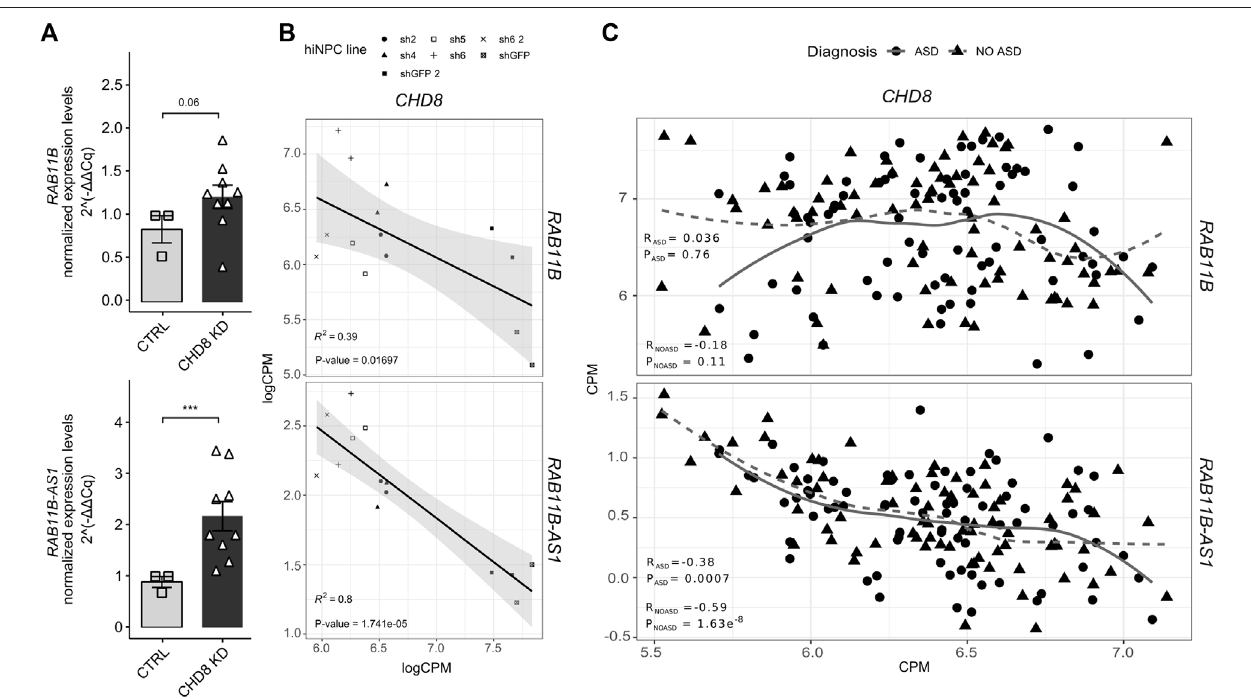
FIGURE 2 | RAB11B-AS1 and CHD8 display inversely correlated expression. (A) The barplots report RAB11B (top) and RAB11B-AS1 (bottom) transcripts quanti fi cation(2 − ΔΔ Cq ),increasingupon CHD8 KD(averageofsh4,sh2,sh1)withrespecttocontrol(shGFPline).DataareplottedasMean ± SEM.Forstatisticalanalysis, un-paired one-tail Student ’ s t -test was performed between control and CHD8 KD lines. N (cid:1) 3 for each line. *** p ≤ 0.001. (B) Dot plots with linear regression line show RAB11B (top) and RAB11B-AS1 (bottom) transcripts abundance (logCPM) with respect to CHD8 levels in hiNPCs with suppressed levels of CHD8 (Sugathan et al., 2014). Linear regression analyses unveiled a signi fi cant inverse correlation for RAB11B ( R 2 (cid:1) 0.39, p (cid:1) 0.01697) and particularly for RAB11B-AS1 ( R 2 (cid:1) 0.8, p (cid:1) 1.741e-05)comparedto CHD8 . (C) Dotplotsdisplaytheabundance(CPM)of RAB11B (top) and RAB11B-AS1 (bottom) comparedto CHD8 fromRNAseqanalysesof peripheral blood samples from ASD patients (ASD diagnosis) and healthy siblings (NO ASD) in the ITAN family cohort. RAB11B-AS1 transcript abundance results in signi fi cativeinversecorrelationrelationshipwith CHD8 bothintheASDpatientsgroup(R (cid:1) − 0.38, p (cid:1) 0.0007)andinthehealthyfamilymembers,i.e.,thecontrolgroup(R (cid:1) – 0.59, p (cid:1)